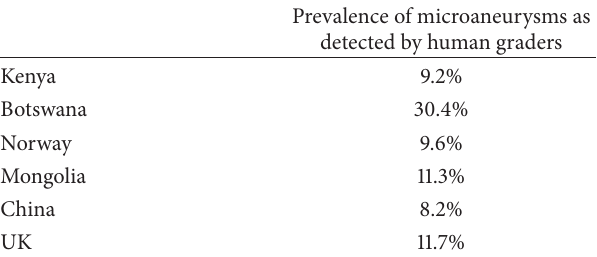
Table 1: Prevalence of microaneurysms within each studied image dataset as determined by human